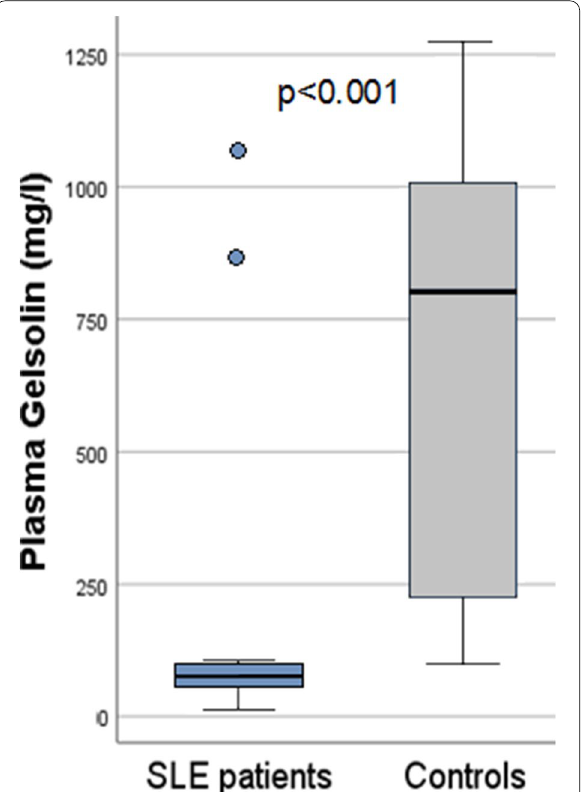
Fig. 1 Plasma gelsolin level in systemic lupus erythematosus (SLE) patients and